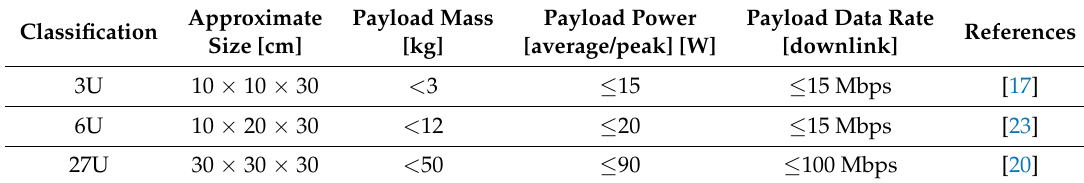
Table 3. Summary of survey of commercial CubeSat platforms capabilities.